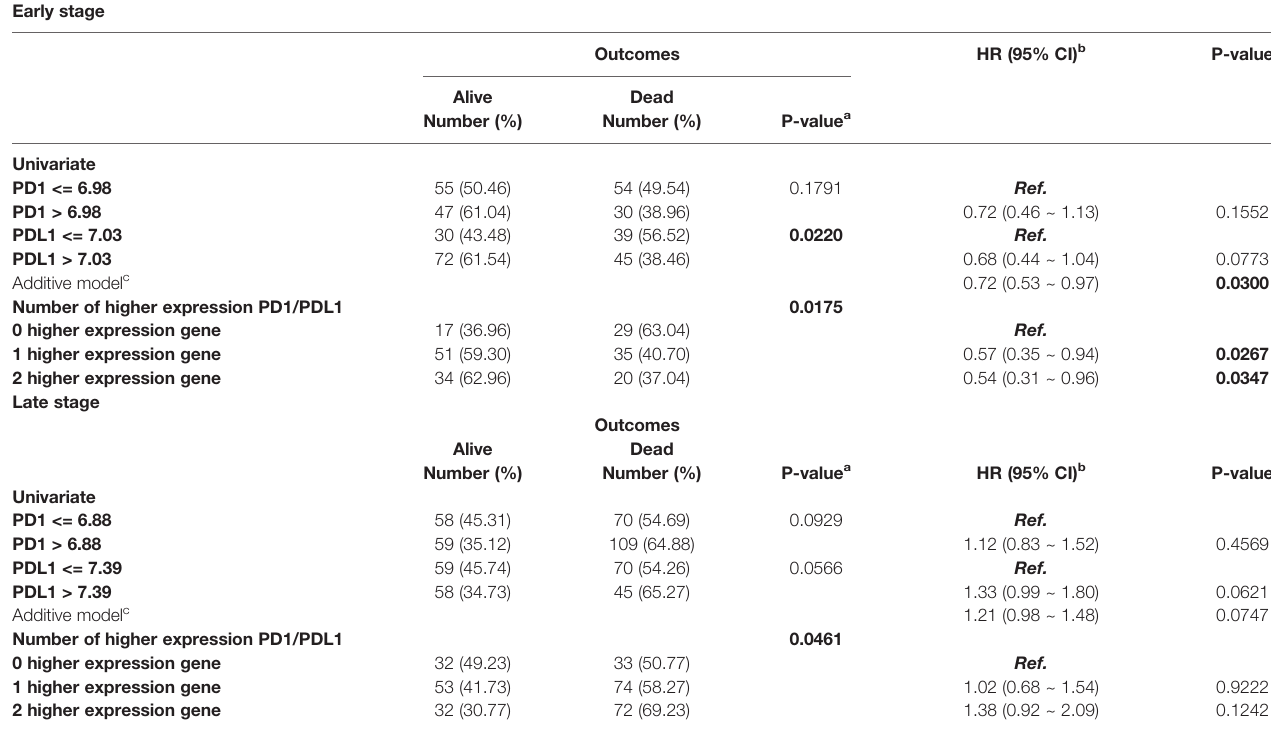
TABLE 5 | Cox regression analyses of PD1 and PDL1 gene expression levels in early and late stage squamous cell carcinoma lung cancer patients. Early stage